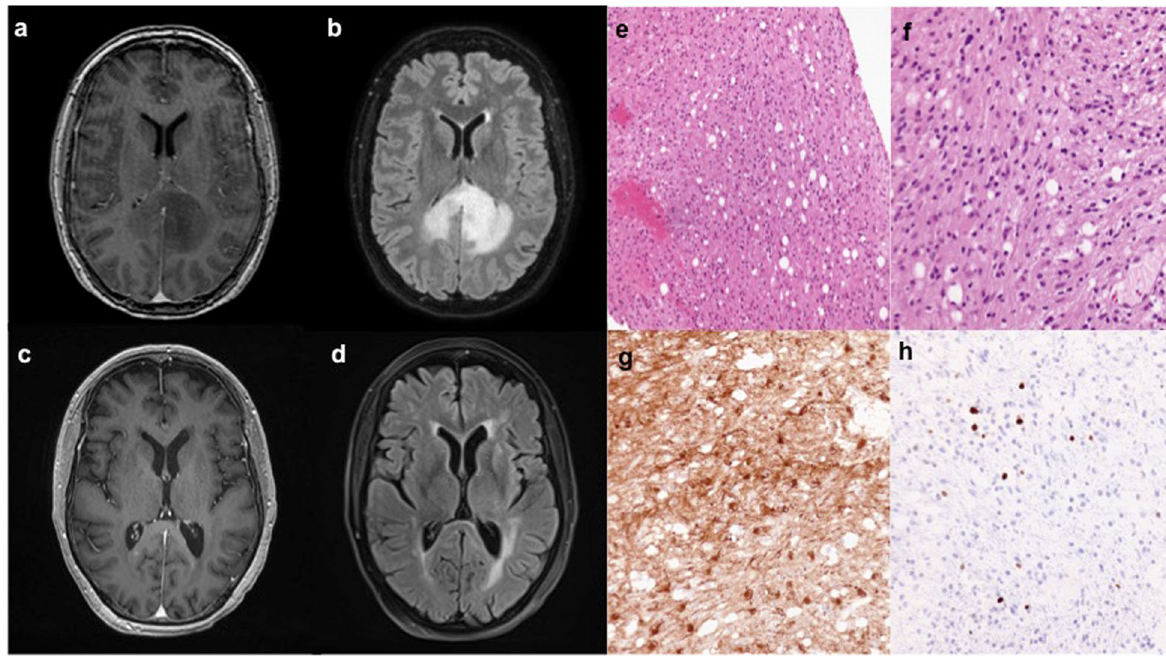
Fig. 1 Imaging and histopathology of the low-grade glioma. a Representative axial slices of T1-weighted MRI after contrast administration and ( b ) T2-weighted FLAIR obtained prior to stereotactic brain biopsy show a predominantly non-enhancing lesion within the deep right parietal lobe with small areas of patchy enhancement that is crossing the corpus callosum with associated edema. Repeat imaging obtained nearly 2 years after biopsy and completion of adjuvant chemoradation demonstrates ( c ) stable foci of small nodular enhancement on T1- weighted MRI after contrast administration with ( d ) minimal associated edema on T2-weighted FLAIR. e , f An in fi ltrating astrocytoma without necrosis or vascular proliferation is seen on hematoxylin & eosin staining. g Immunohistochemistry for GFAP-positive tumor cells is shown and ( h ) the Ki-67 proliferative index was